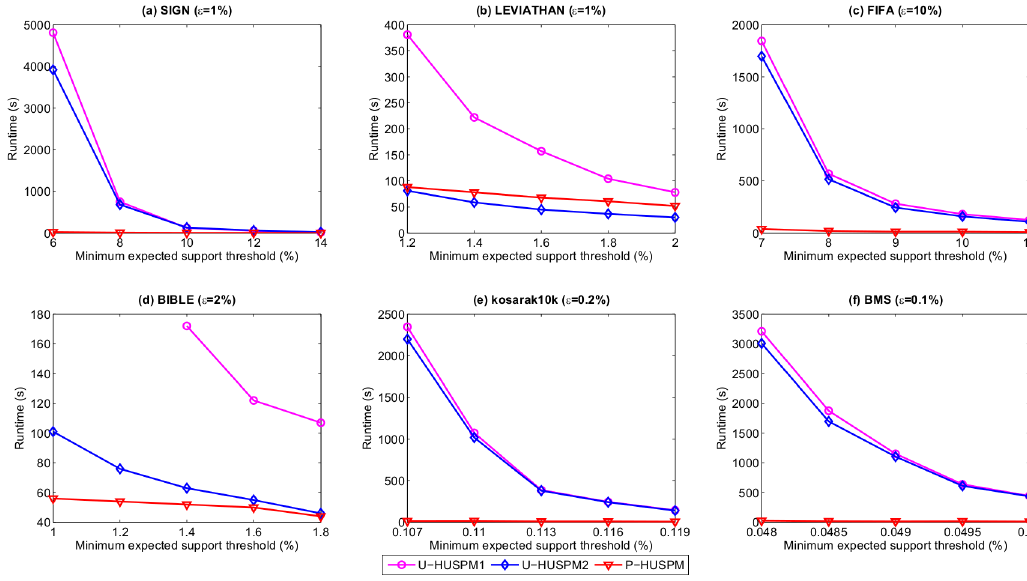
Fig 2. Runtimes for a fixed ε and various μ